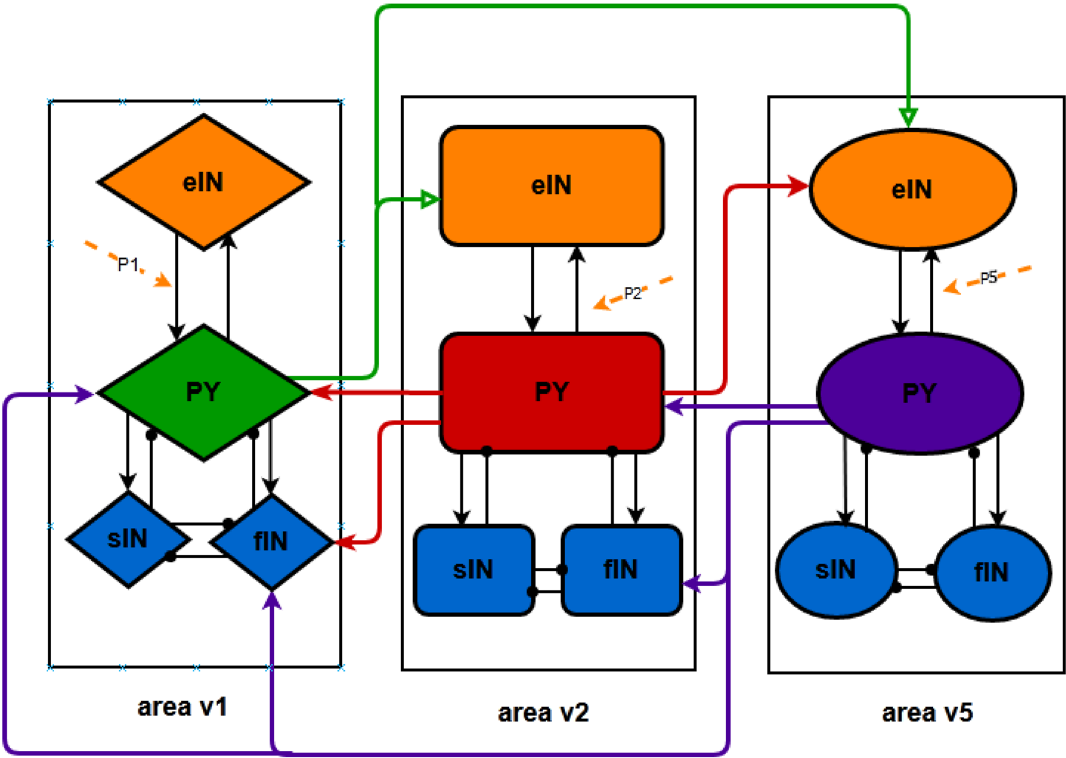
Figure 1. Diagram of the model sketch for the dorsal visual pathway. This neural mass model included three interconnected cortical areas of v1, v2, and v5. Each cortical area is composed of four neuron populations of PY, eIN, sIN and fIN. Black arrows represent excitatory synaptic connection and black rounds represent inhibitory synaptic connection in the single cortical area. Green arrows denote long synaptic projections from area v1 to v2 and v5; red arrows denote long synaptic projections from area v2 to v1 and v5; purple arrows denote long synaptic projections from area v5 to v1 and v2; orange-colored arrows denote Gaussian white noise which represents exogenous afferent from other connected areas not included in this